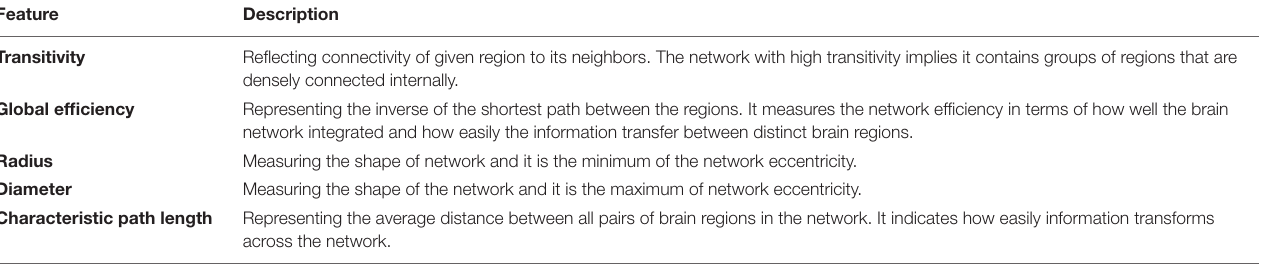
TABLE 2 | List of graph parameters that used for characterizing a functional brain network. Feature